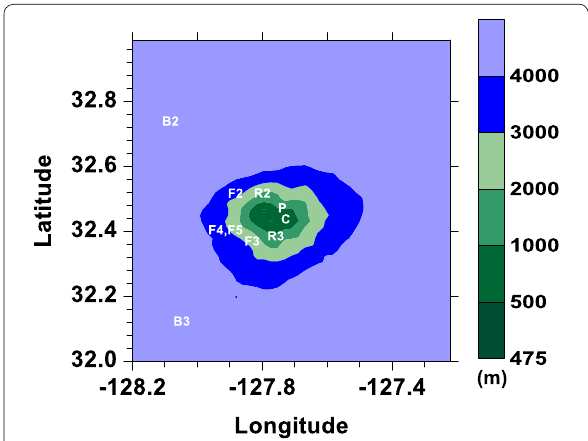
Fig. 1 The bathymetry of Fieberling Guyot with the locations of nine moorings indicated by B2, B3, F2, F3, F4, R2, R3, P, and C